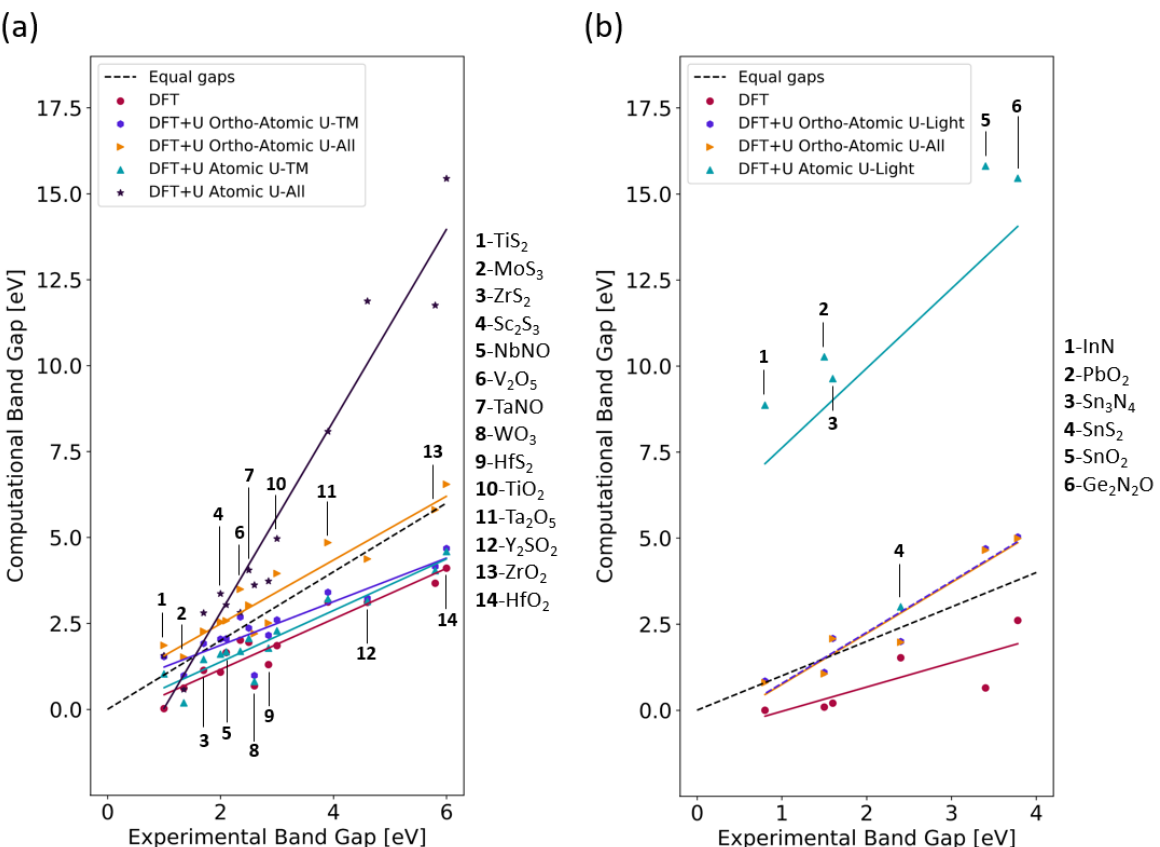
Figure 2. Comparison of the computationally predicted band gaps (from DFT and DFT+ U ) and the experimental band gaps for materials containing ( a ) TM elements, and ( b ) p -block (group III-IV) elements of the periodic table. The dashed black line indicates where the computational band gap equals the experimental band gap. Data was fit to first order polynomials so that data points from DFT and different DFT+ U calculations could be more easily compared using the resulting solid trendlines (note that all data points were included in these fits). DFT+ U calculations were performed using atomic and ortho-atomic projectors. On panel ( a ), the legend also indicates whether U corrections are applied to only d states of the TM elements ( U -TM), or to the d states of TM and p states of light elements ( U -All). On panel ( b ), the legend also indicates whether U corrections are applied to p states of light elements ( U -Light), or to p states of light and p -block (group III-IV) elements ( U -All). Note that in panel ( b ), the “DFT+ U Ortho-Atomic U-Light” trendline (blue) is dashed so that the “DFT+ U Ortho-Atomic U-All” trendline (orange) can also be